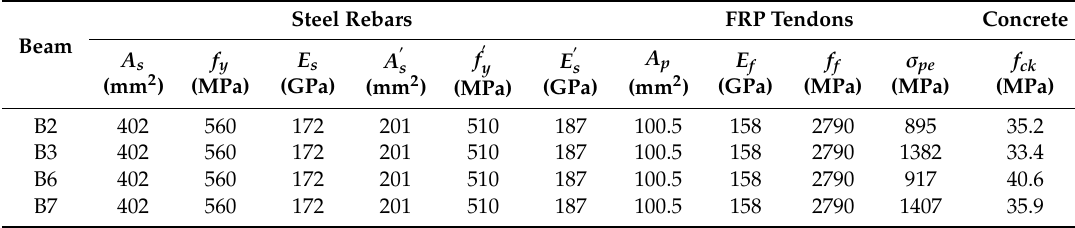
Table 1. Material parameters for specimens [20].